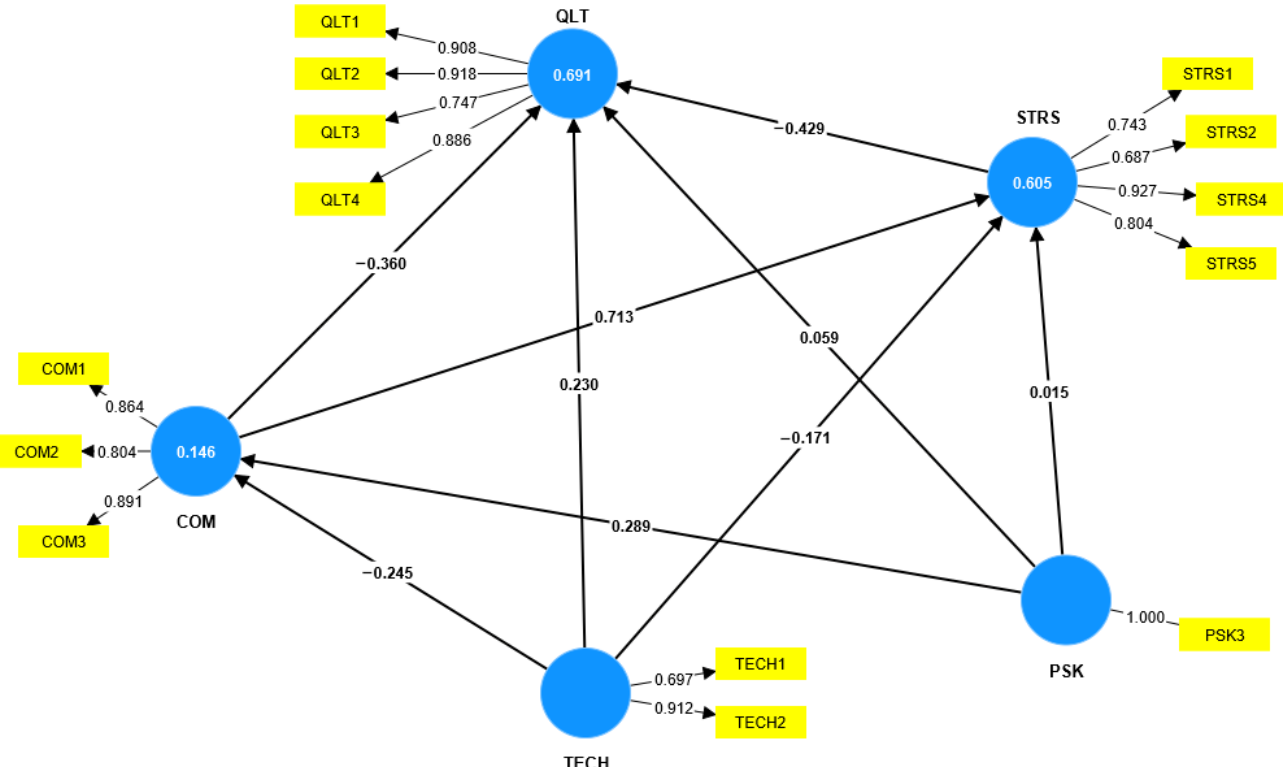
Figure 3. PLS-SEM algorithm applied to the changed model. Source: Own work using SmartPLS, version 4. Table 3. The descriptive statistics of the items kept in the model.